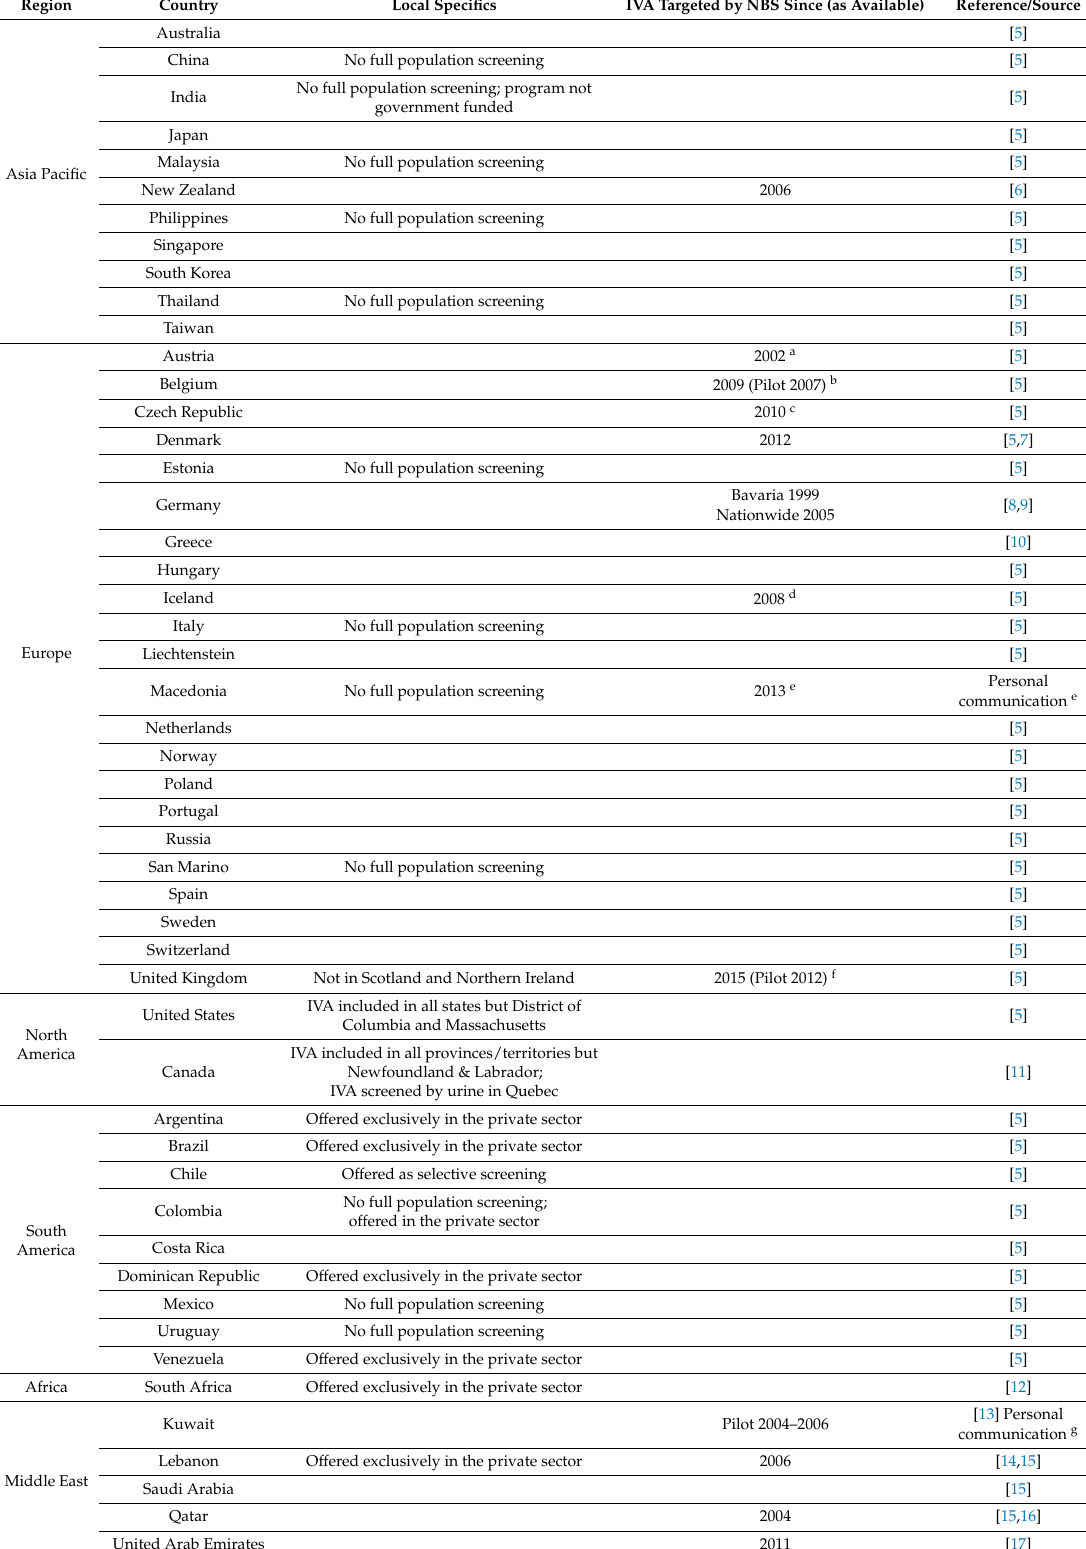
Table 1. Countries with published experience in NBS for IVA. Region